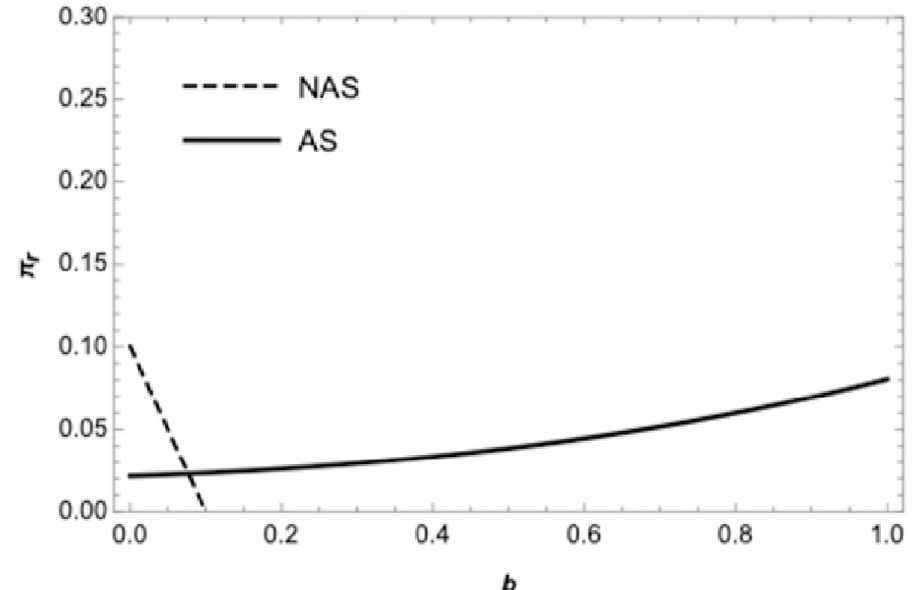
Fig 3. The retailer’s profit in the quantity discount